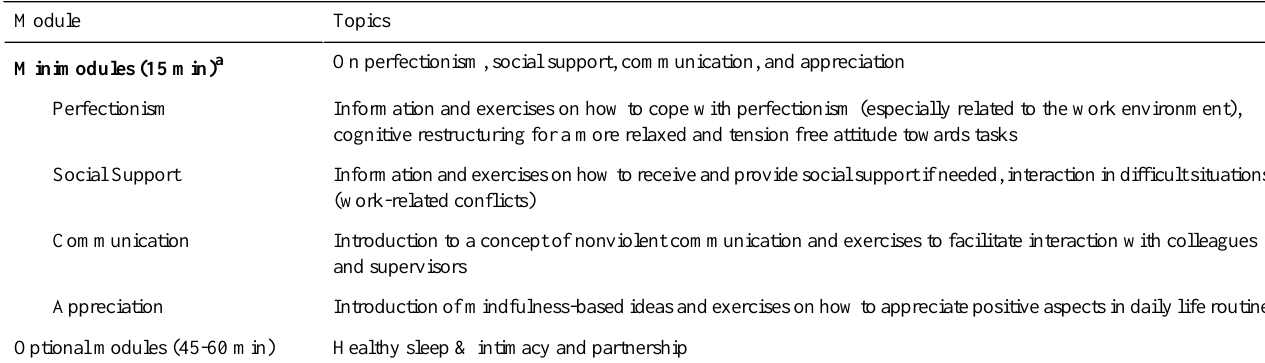
Table 2. Content of the optional and minimodules in the Get.Back